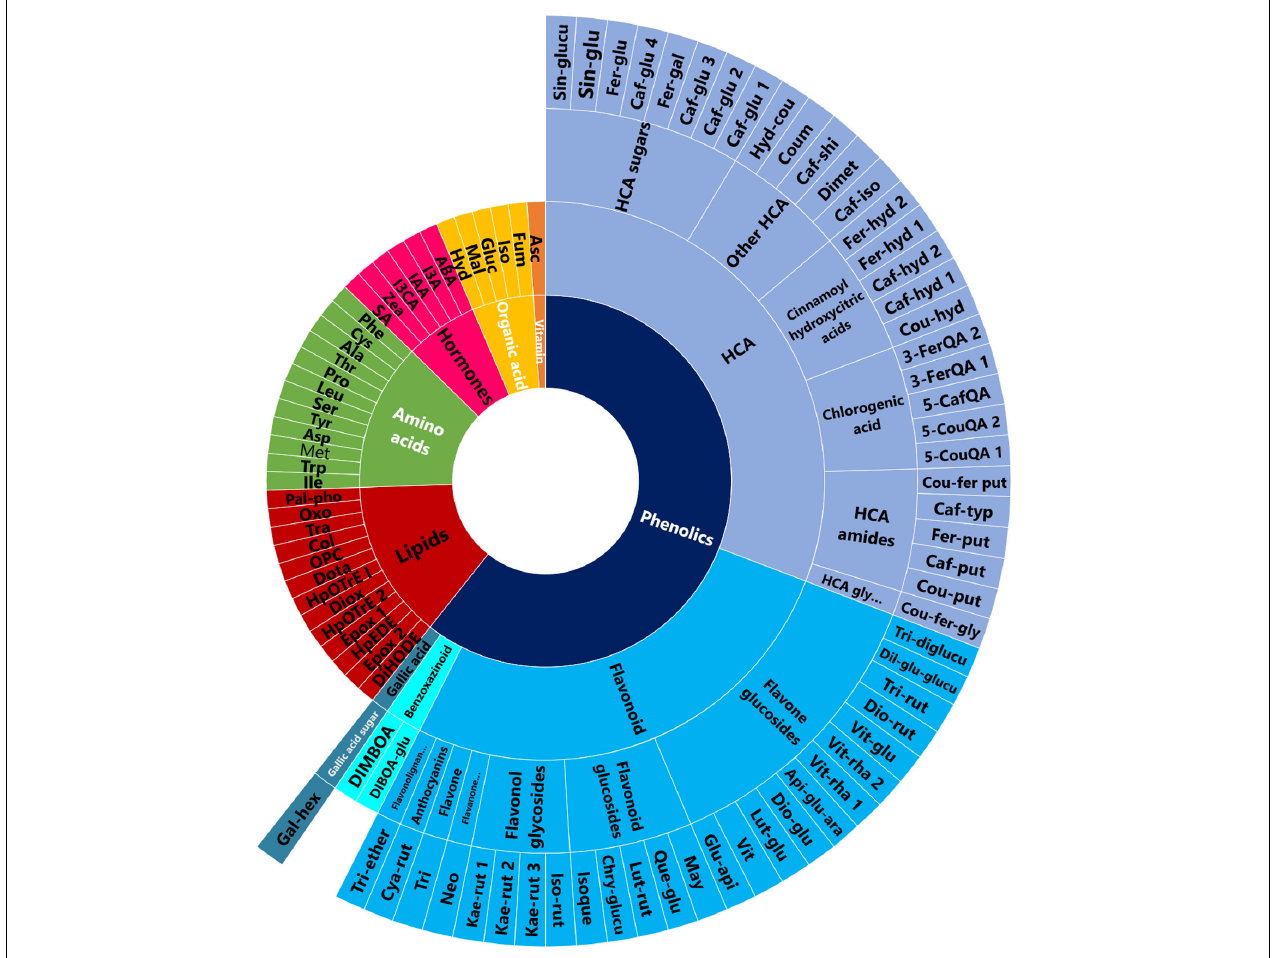
FIGURE 1 | PGPR-induced metabolic changes spanned various classes of metabolites. A sunburst plot showing the classification of all the putatively annotated metabolites, and amino acids and hormones which were identified using targeted analysis. Refer to Supplementary Tables 1, 2 for the full names of the metabolites shown in this sunburst